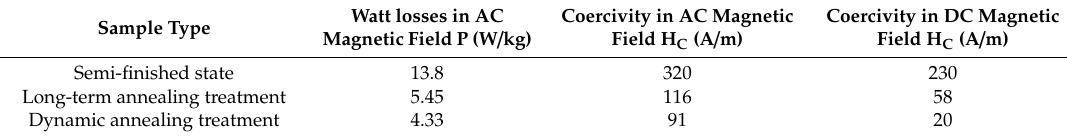
Table 1. The magnetic properties of chosen samples of investigated segments.